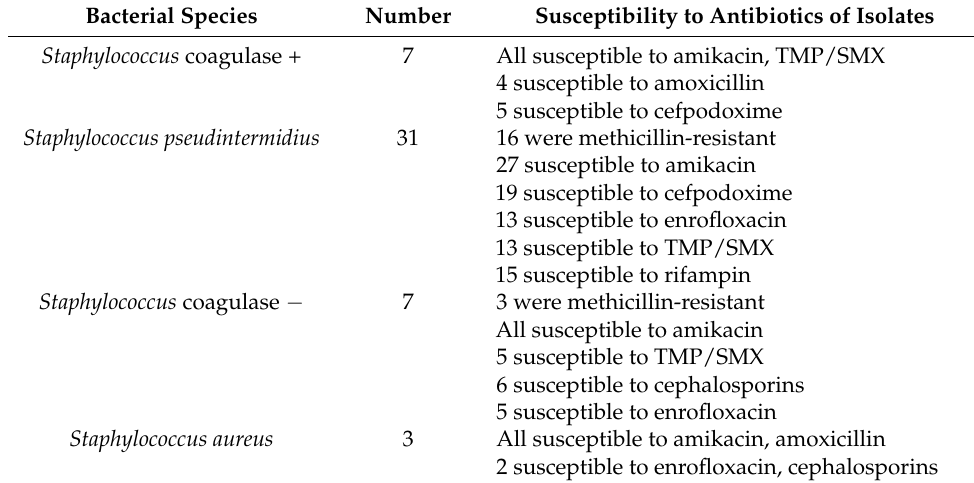
Table 4. Staphylococcus sp. isolates from diverse sites in the cancer patient population. Bacterial Species Number Susceptibility to Antibiotics of Isolates Staphylococcus coagulase + 7 All susceptible to amikacin, TMP/SMX 4 susceptible to amoxicillin 5 susceptible to cefpodoxime Staphylococcus pseudintermidius 31